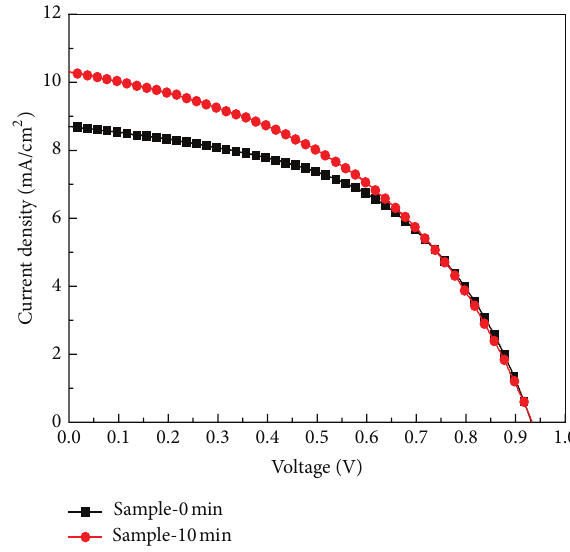
Figure 10: 𝐽 - 𝑉 characteristic curves of the optimum MPSCs depending on the drying time of 0min (black) and 10min (red).